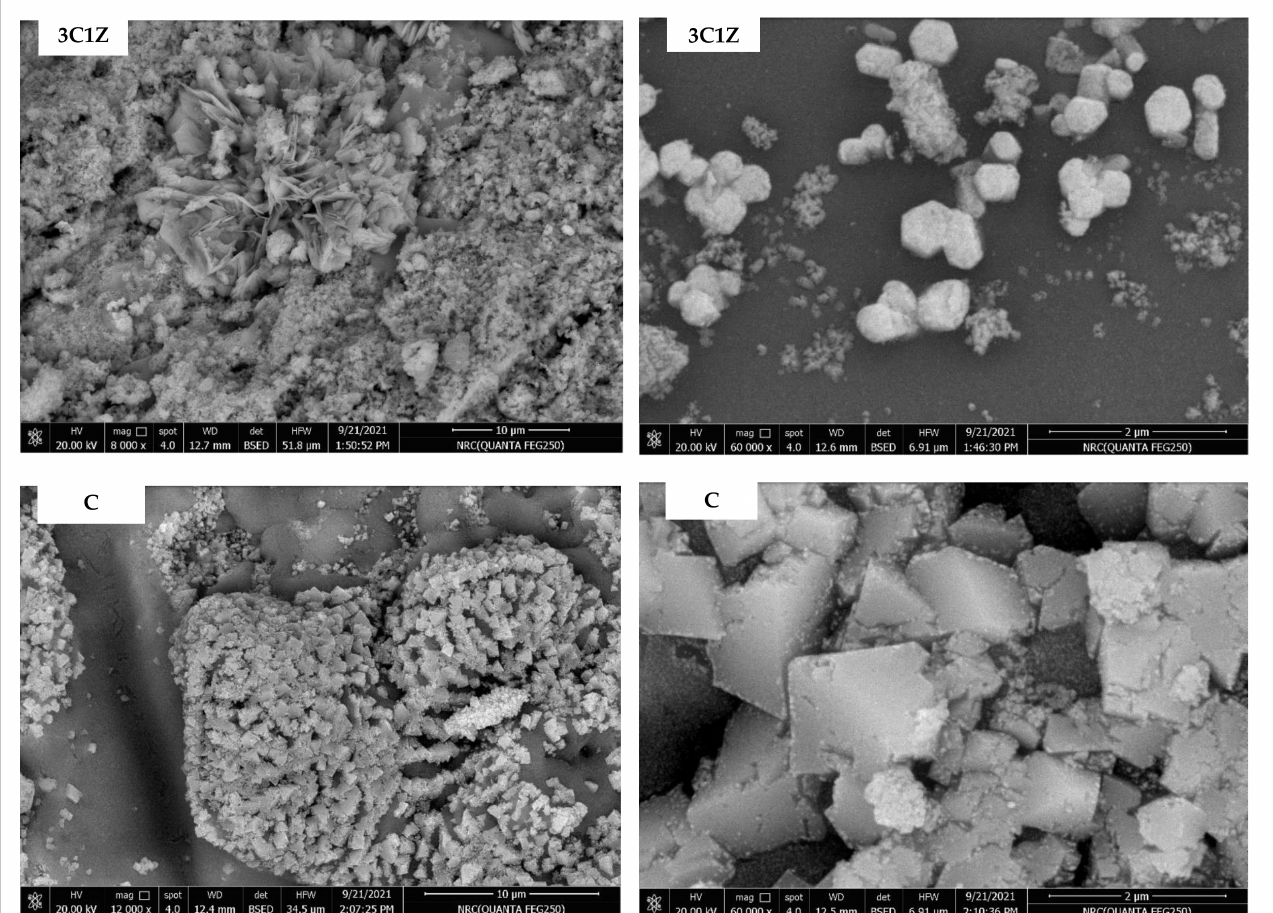
Figure 3. SEM images of Z, 1C3Z, 1C1Z, 3C1Z, and C greenly prepared via hydrothermal route (pH = 10, T = 250 ◦ C, t = 2.5 h) and calcination for 2 h at 300 ◦